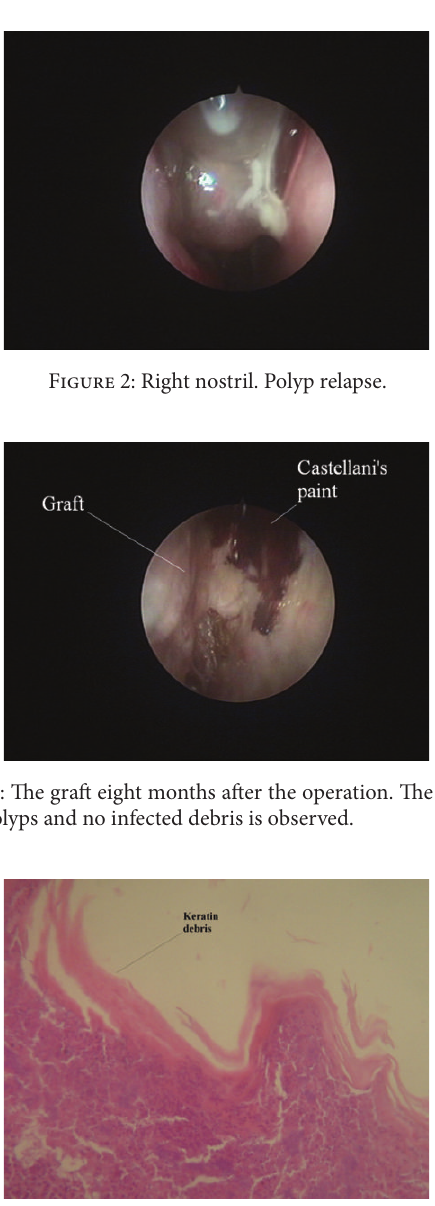
Figure 4: Biopsy specimen: horny keratin layer of epidermal type with underlying chronic and acute inflammatory cells. Magnifica- tion: × 100, tissue stain: